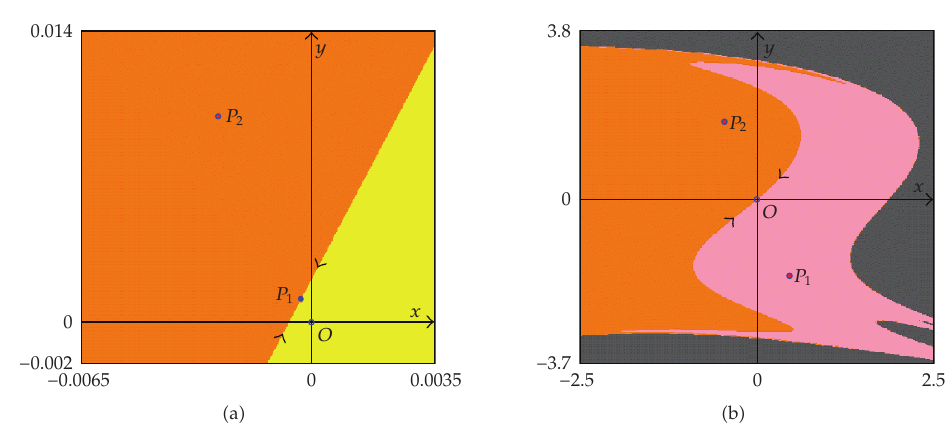
Figure 7: Change of stability in the two-dimensional case. Parameters are a H (cid:8) 0 . 41 ,b H (cid:8) 0 . 11 ,c H (cid:8) 0 . 83 ,γ H (cid:8) 0 . 3 ,F H (cid:8) 4 . 279 ,F S (cid:8) 6 . 07 ,d (cid:8) 0 . 35 , and f (cid:8) 0 . 7. In (cid:5) a (cid:6) , at e (cid:8) 0 . 124697 , the attractors are the fixed points P 2 and O , their basins are bounded by the stable manifold of P 1 . In (cid:5) b (cid:6) , at e (cid:8) 2 . 22 , the attractors are P 1 and P 2 , the border between basins B 1 and B 2 is the stable manifold of the fundamental equilibrium O